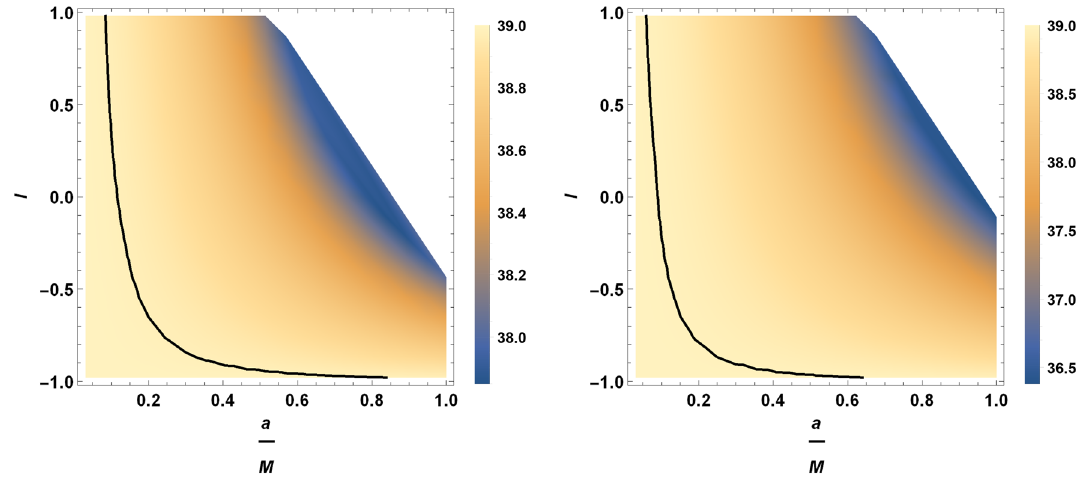
Fig. 24 The observable for angular diameter θ d as a function of black hole parameters. The left one is for k = 0 . 1, b = 0 . 1, and angle of inclination θ = 90 ◦ . The right one is for k = 0 . 1, b = 0 . 1, and θ = 17 ◦ . Black solid lines correspond to θ